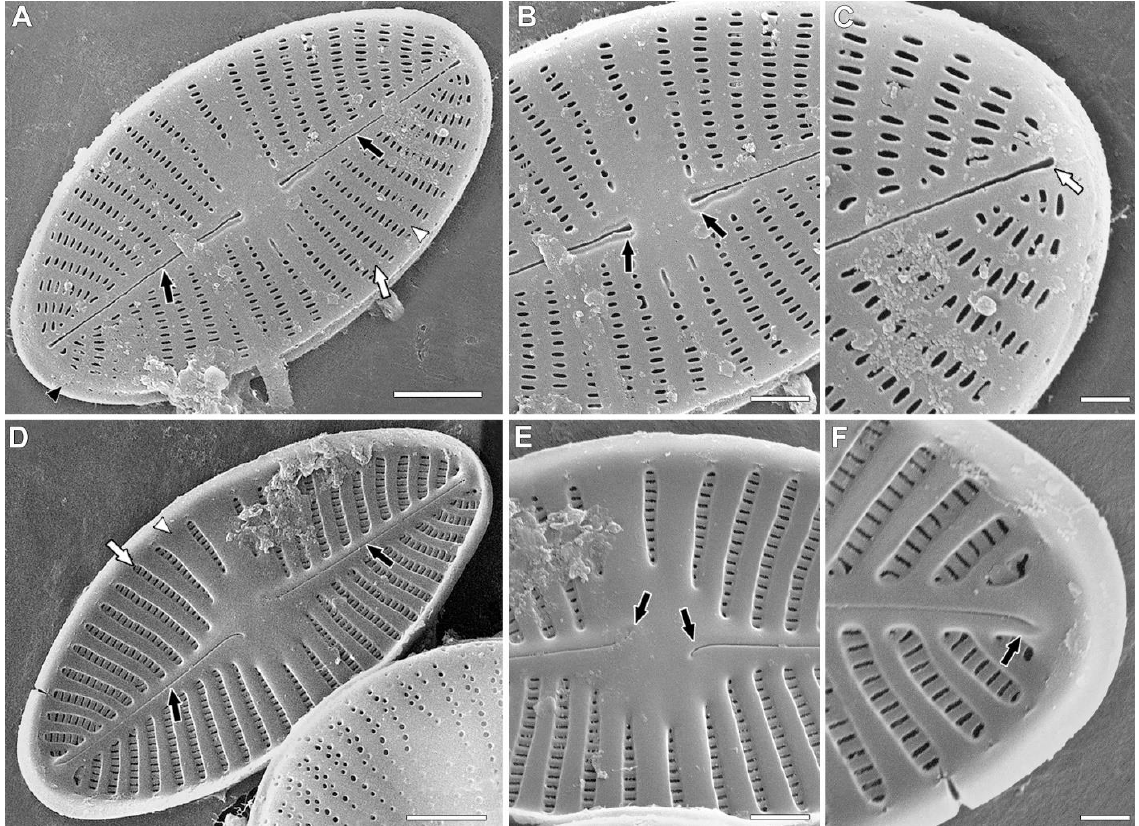
Figure 2. Planoplatessa joursacensis (Héribaud) Kulikovskiy, Glushchenko & Kociolek comb. nov. Scanning electron microscopy. Raphe valves. ( A ). The entire valve, external view. Black arrows show the filiform and straight raphe. White arrow shows the uniseriate stria. Black arrowhead shows the valve mantle. White arrowhead shows the interstria. (B). Central area, external view. Black arrows show the central raphe ends. ( C ). Valve end, external view. White arrow shows the distal raphe end. ( D ). The whole valve, internal views. Black arrows show the filiform and straight raphe. White arrow shows the uniseriate stria. White arrowhead shows the interstria. ( E ). Central area, internal view. Black arrows show the deflected in opposite directions central raphe ends. ( F ). Valve end, internal view. Black arrow shows the helictoglossa. Scale bar ( A, D ) = 2 μm; ( B, E ) = 1 μm; ( C, F ) = 0.5 μm.